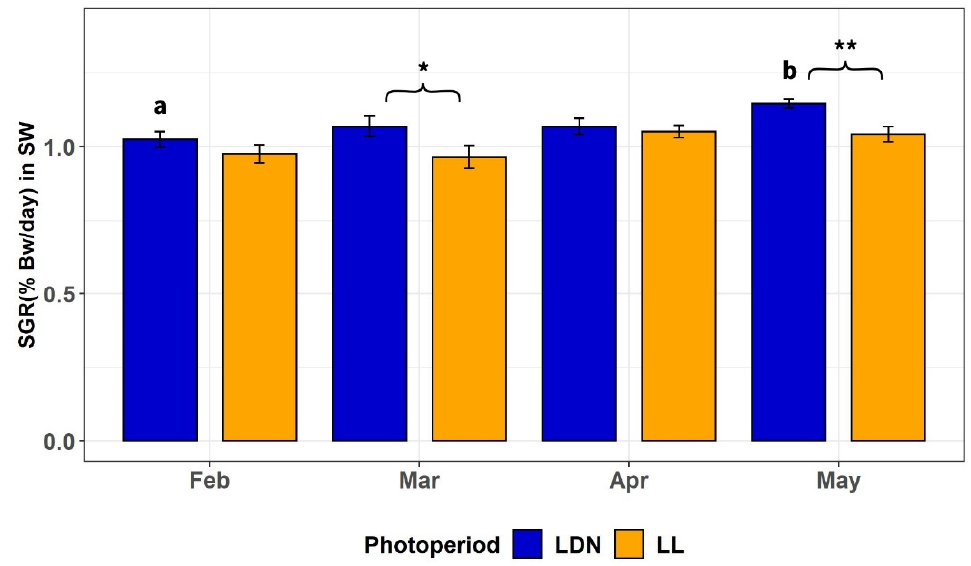
Figure 6. The specific growth rate in seawater (SGR, % body weight gain per day) of individually tagged fish that had been reared under LDN or LL photoperiods and transferred to seawater at different months. Asterisks represent significant differences (two-way nested ANOVA) between photoperiod groups transferred in the same month, as follows: (*) p < 0.05; (**) p < 0.01. Letters “a” and “b” indicate significant differences (Tukey post hoc test, p < 0.05) between groups reared under the same photoperiod but transferred to seawater at different times. Vertical lines indicate SEM.